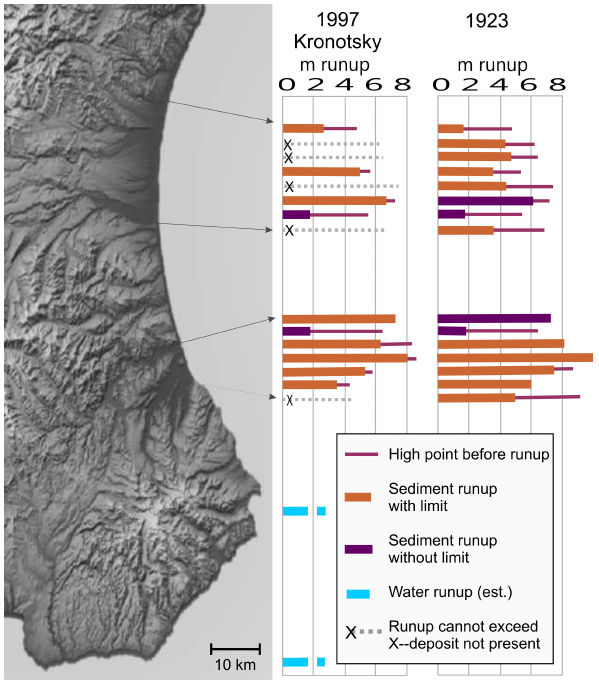
Figure 6. Water runup (Zayakin and Pinegina, 1998) and sediment runup (this paper, Table 3) for the 1997 Kronotsky tsunami on and north of the Kronotsky Peninsula, southern Kamchatsky Bay (loca- tions in Fig. 1; also see Fig. S2). Water runup was not measured with instruments but was estimated; tsunami did not exceed the unvege- tated beach (e.g., Fig. 3); it could have been somewhat higher than reported, shown on this figure by dashed blue line. Sediment runup is also illustrated for the tsunami deposit closely above KS 1907 , which we interpret as from 1923 February or April (see text discus- sion). Sediment inundation is given in Table 3, as well as latitudes and longitudes for the 15 profiles. Figures 4 and 5 illustrate methods and